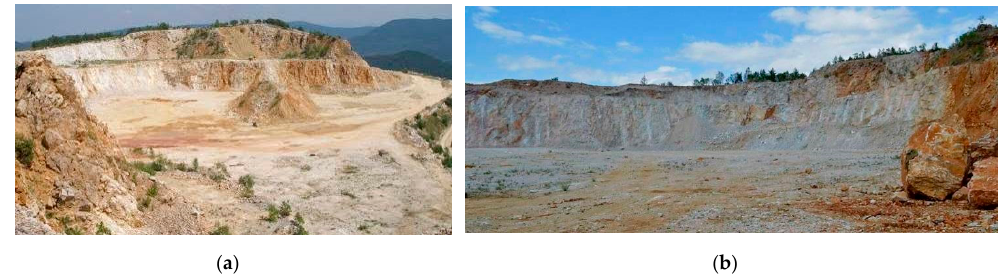
Figure 3. Views of the pit benches in the open-pit mine. ( a ) Eastern view to the open-pit mine; ( b ) Northeast view from the pit bottom.